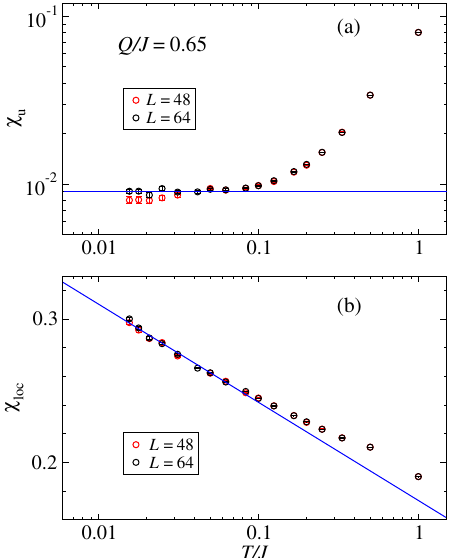
FIG. 21. Temperature dependence of the uniform (a) and local (b) susceptibility of the bimodal random- J model at its estimated =J ≈ 0 . 65 [see Fig. 15(b)]. The horizontal line in critical point Q c (a) indicates the size-independent behavior expected from Eq. (16) if z ¼ 2 , while the line in (b) is a fit to logarithmic form in Eq.